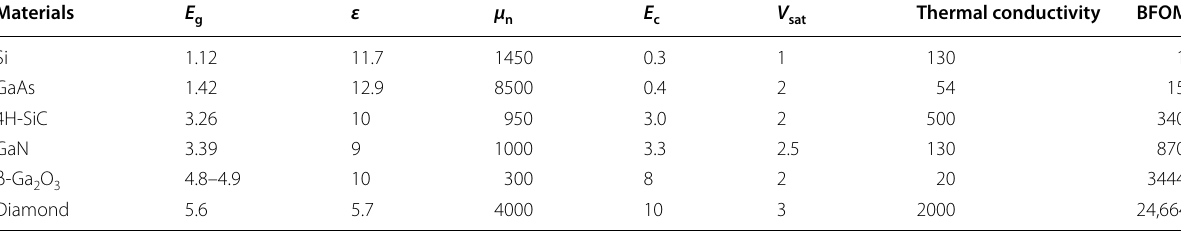
O , and diamond 2 3